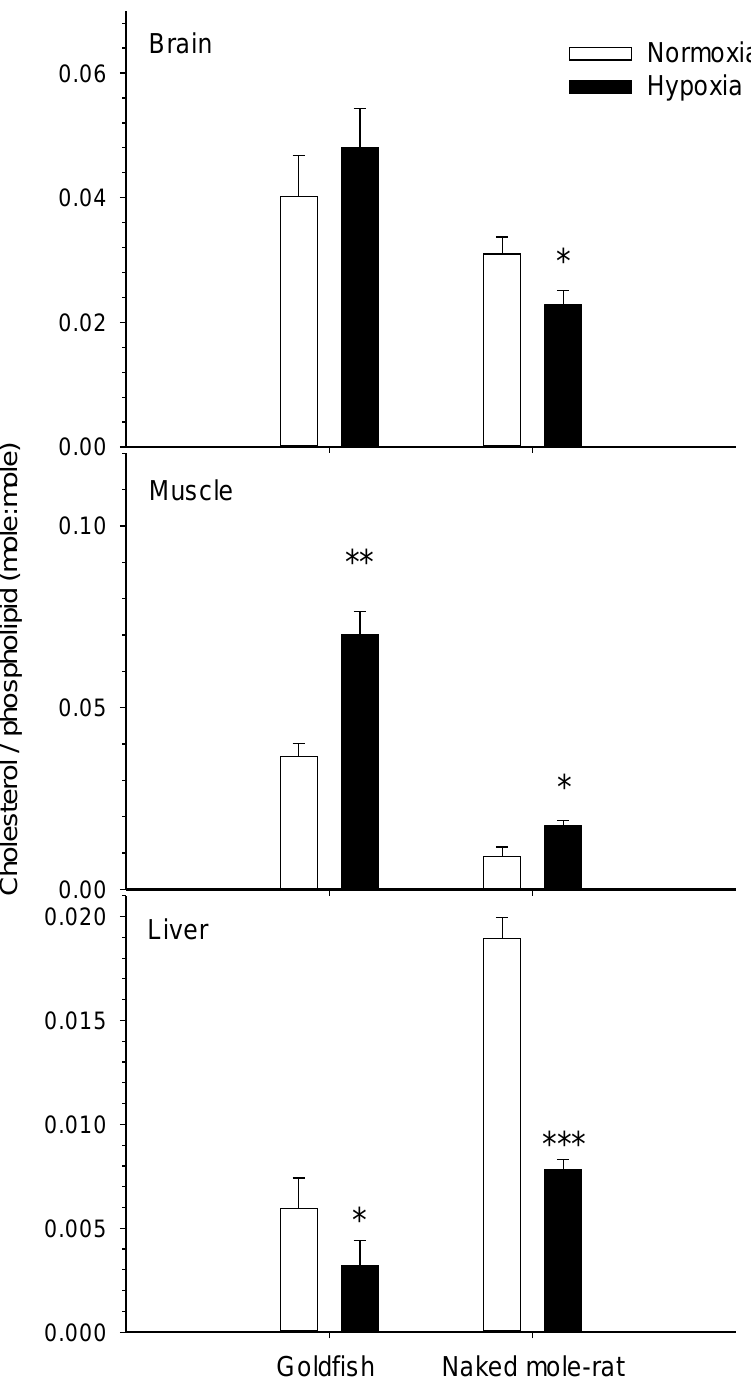
Figure 1. Relative membrane cholesterol in the tissues of normoxic controls and hypoxia-acclimated animals for two hypoxia-tolerant vertebrates: the goldfish [14] and the naked-mole rat [15]. Values are means ± SEM ( n = 9–16 per treatment). * p < 0.05, ** p < 0.01, *** p < 0.001 indicate significant effects of hypoxia.